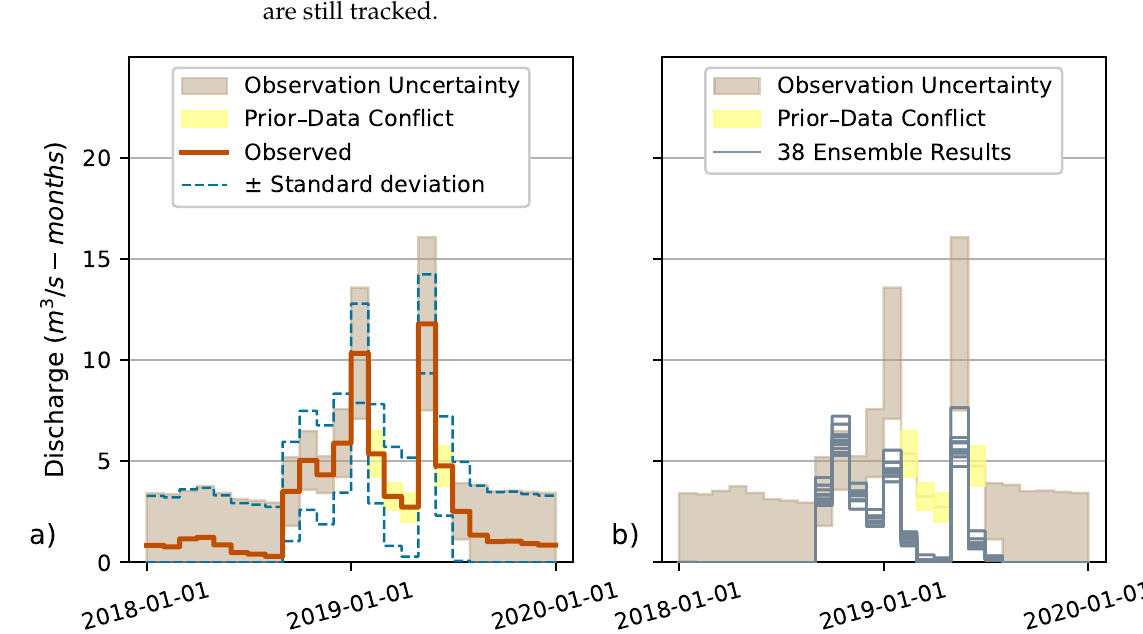
Figure 7. PESTPP-IES uncertainty analysis results for 8171290. Panel ( a ) displays observed discharge and observation uncertainty descriptions. “Observation uncertainty” is the RMSE, calculated as described in Section 2.3, or the expected uncertainty envelope. The standard deviation of the observed discharge time series is displayed for comparison, and “ ± Standard deviation” provides an independent estimate of observation uncertainty. The expected uncertainty envelope is tighter, or narrower, relative to the standard deviation envelope at low and medium discharges and is larger at high discharges. Prior-data conflicts are observed values that the model cannot reproduce, when including observation uncertainty with observed values. Panel ( b ) shows simulated discharges from 38 best-fit, parameter ensembles. These 38 best-fit ensembles achieve a Φ threshold that identifies the overall best-fit parameter ensembles and produce a Σ NK values from 0.26 to 0.71. In Table 6, Σ NK for 8171290 range from a minimum of 0.25 to a maximum of 0.85 with a mean value of